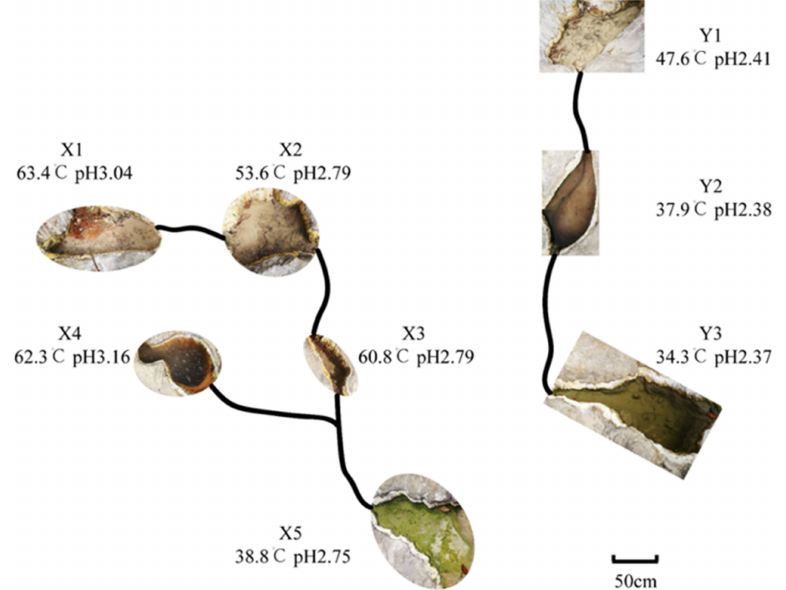
Figure 1. Map showing the eight sampling sites along the two